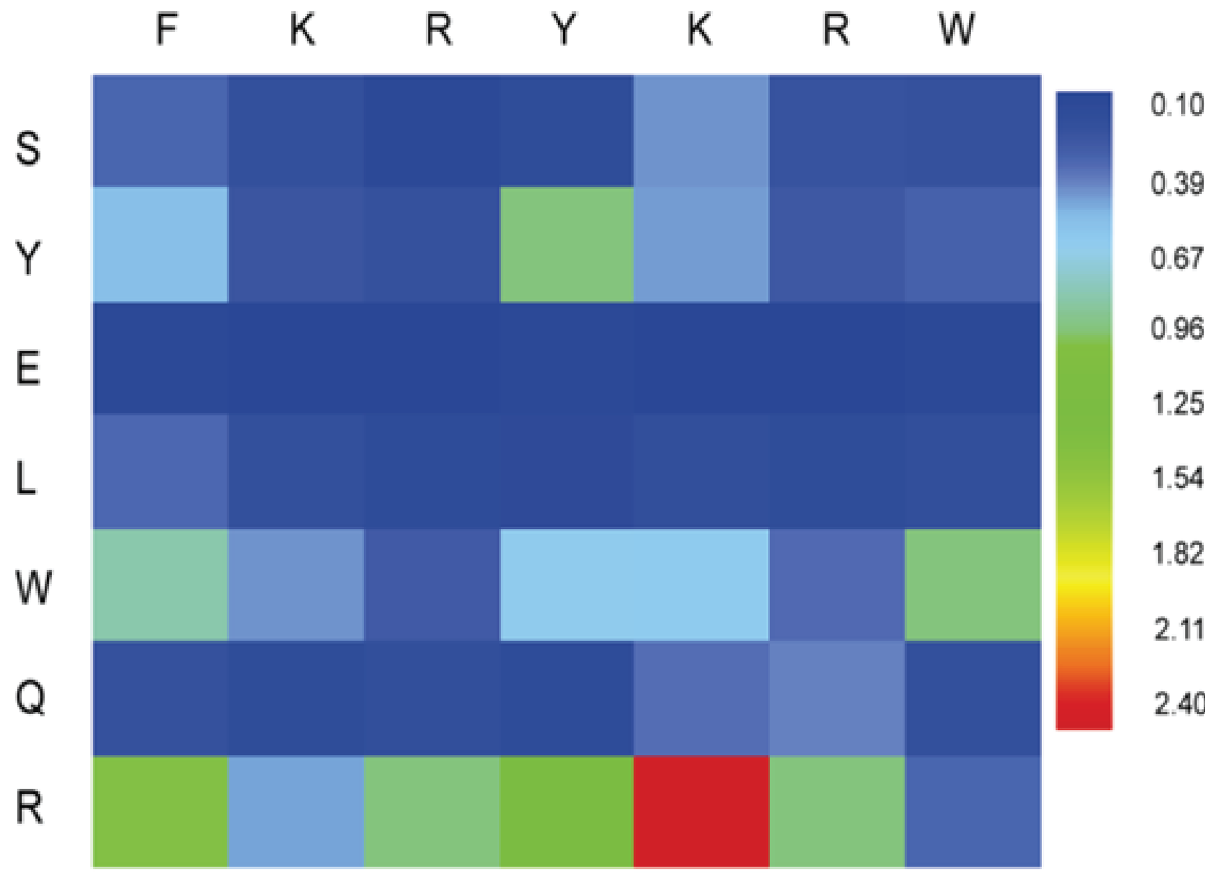
Fig 4. Point-variant screening of nPEP-1 “FKRYKRWGSC”. The point-variant screeningis performed at each of the 7 N-terminal positionswith a substitutionset of S, Y, E, L, W, Q, and R. The inhibitionof β -Gal by variants was normalized to the inhibitionpercentage value of the nPEP-1 at 20 μ